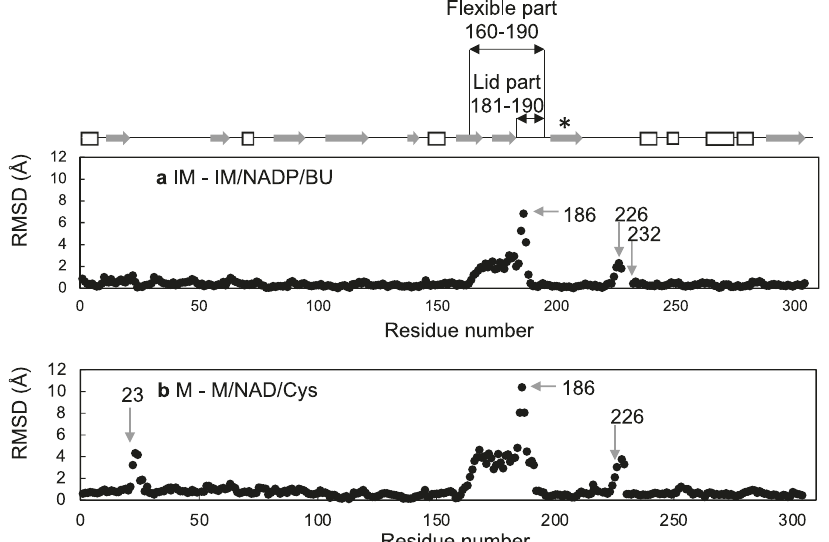
Fig. 5 Conformational change induced by ligand binding. Differences between the backbone atoms of the IM and IM/NADP/BU ( a ) and M and M/NAD/ Cys ( b ) structures are superimposed. The arrows and numbers indicate the residues mentioned in the text. The a-helix and b-sheet structures are shown in arrows and white boxes, respectively. The fl exible (160 – 190 aa) and lid part (181 – 190 aa) are shown by two-way arrow. The helix structure (194 – 210 aa) described in Fig. 6 is marked with an asterisk.